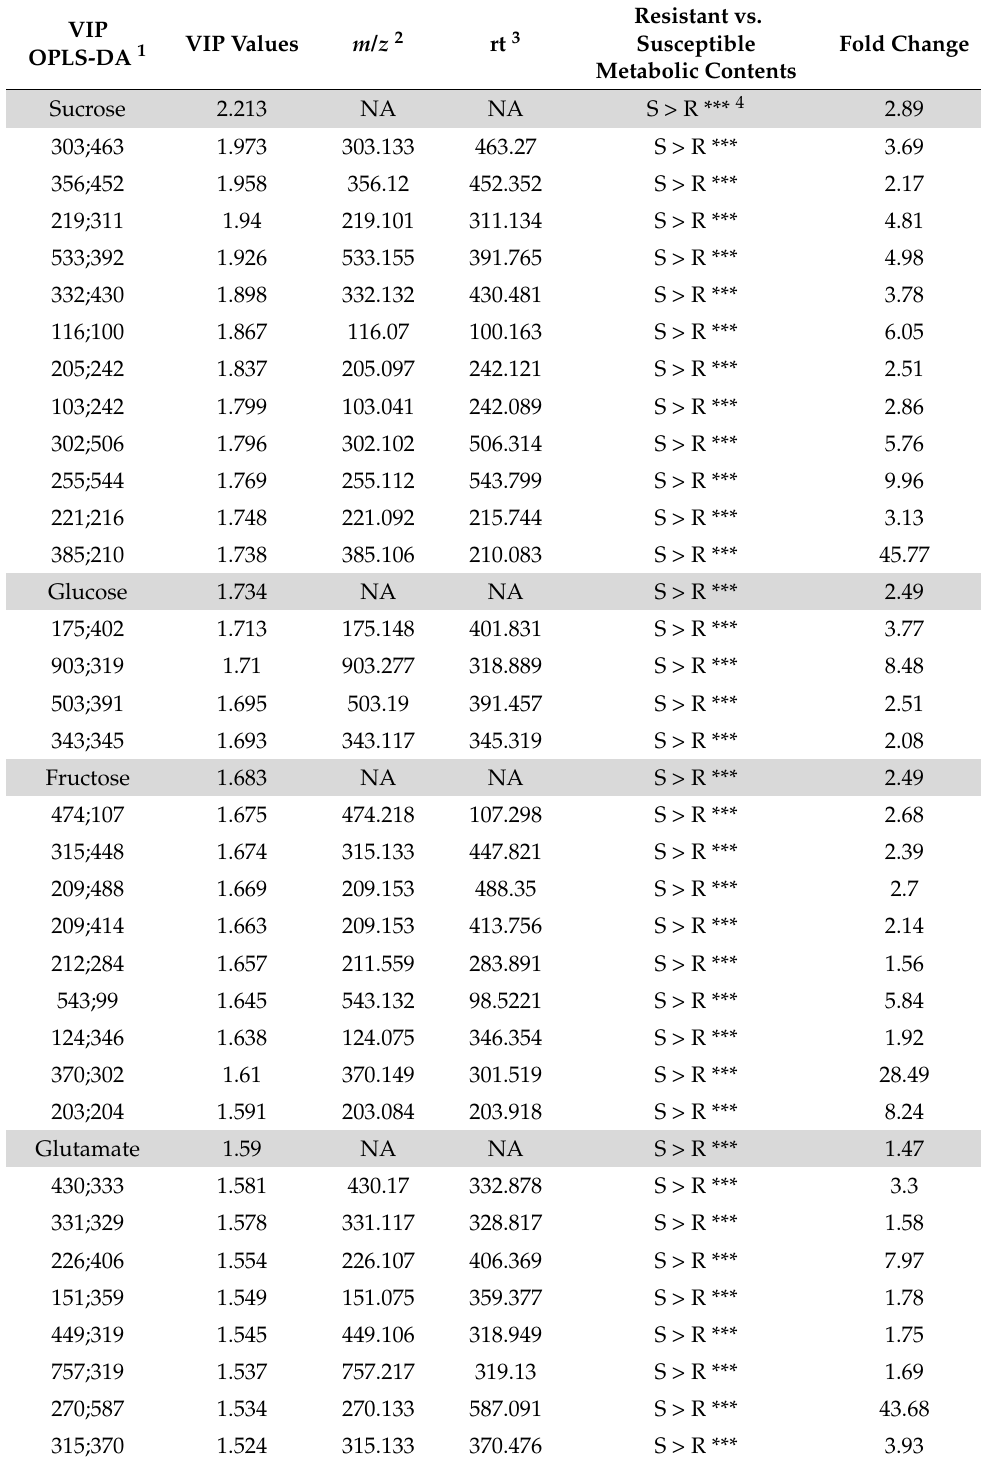
Table 2. List of the variable importance in the projection (VIPs) identify by OPLS-DA analysis performed on TuMV-inoculated resistant and susceptible twenty-six accessions in 2015. For each VIP, comparisons between resistant (R) and susceptible (S) accessions were done. The fold change was calculated for each VIP. Primary metabolites are light-grey highlighted. Metabolites that accumulate significantly more in resistant accessions are at the bottom of the